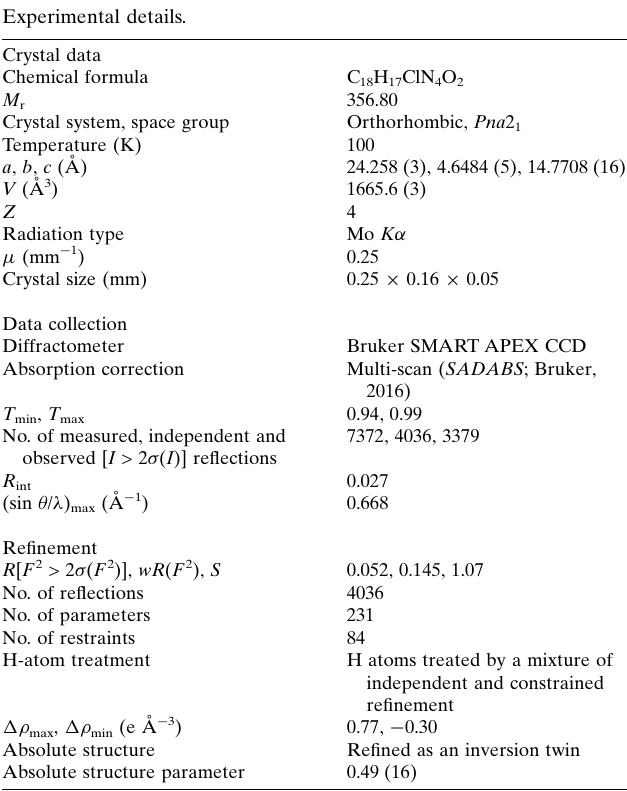
Table 2 Experimental